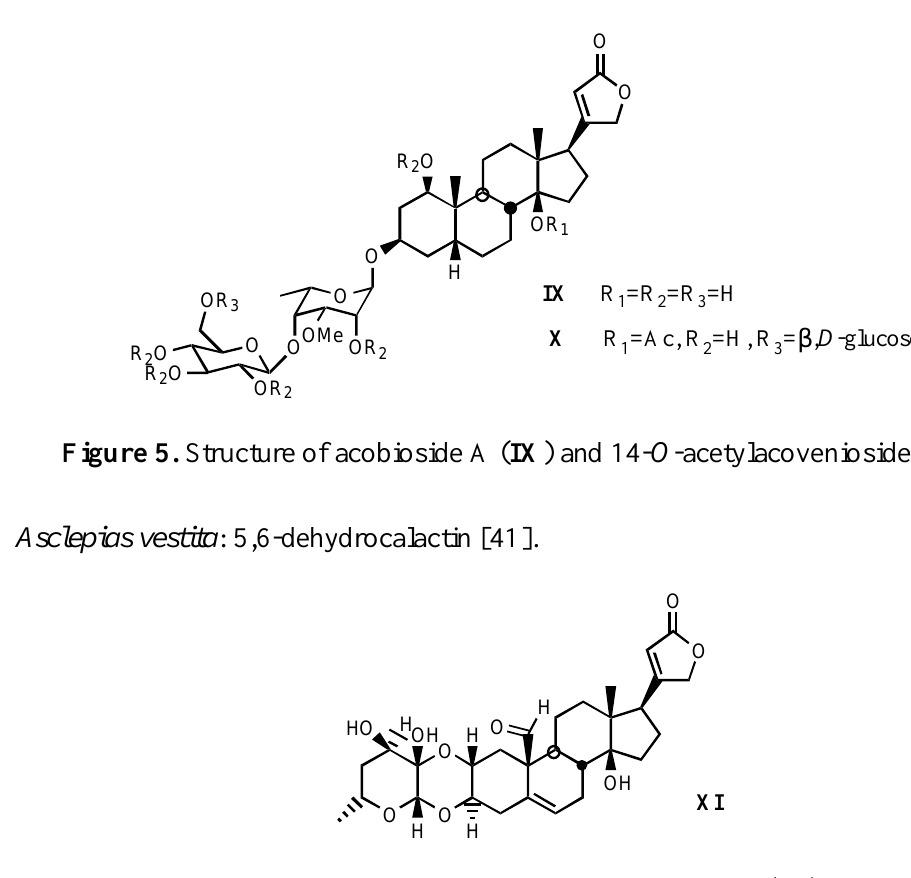
Figure 6. Structure of 5,6-dehydrocalactine ( XI ).